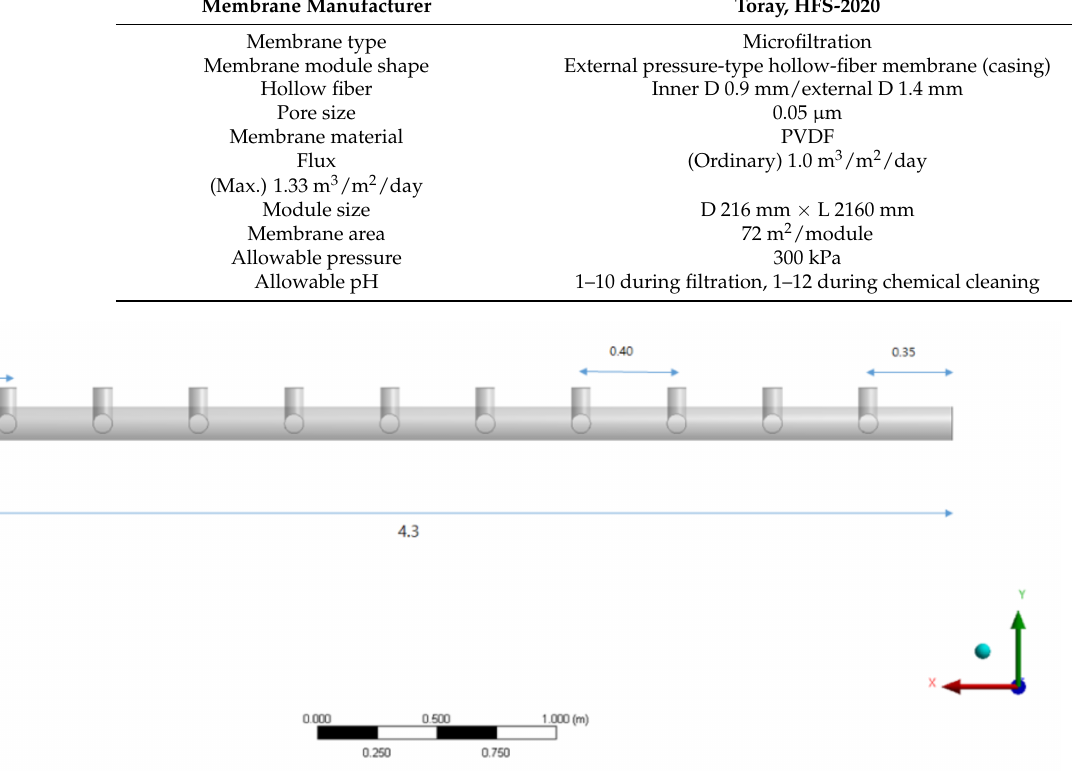
Figure 2. Geometry of inlet header and manifold pipes (units: